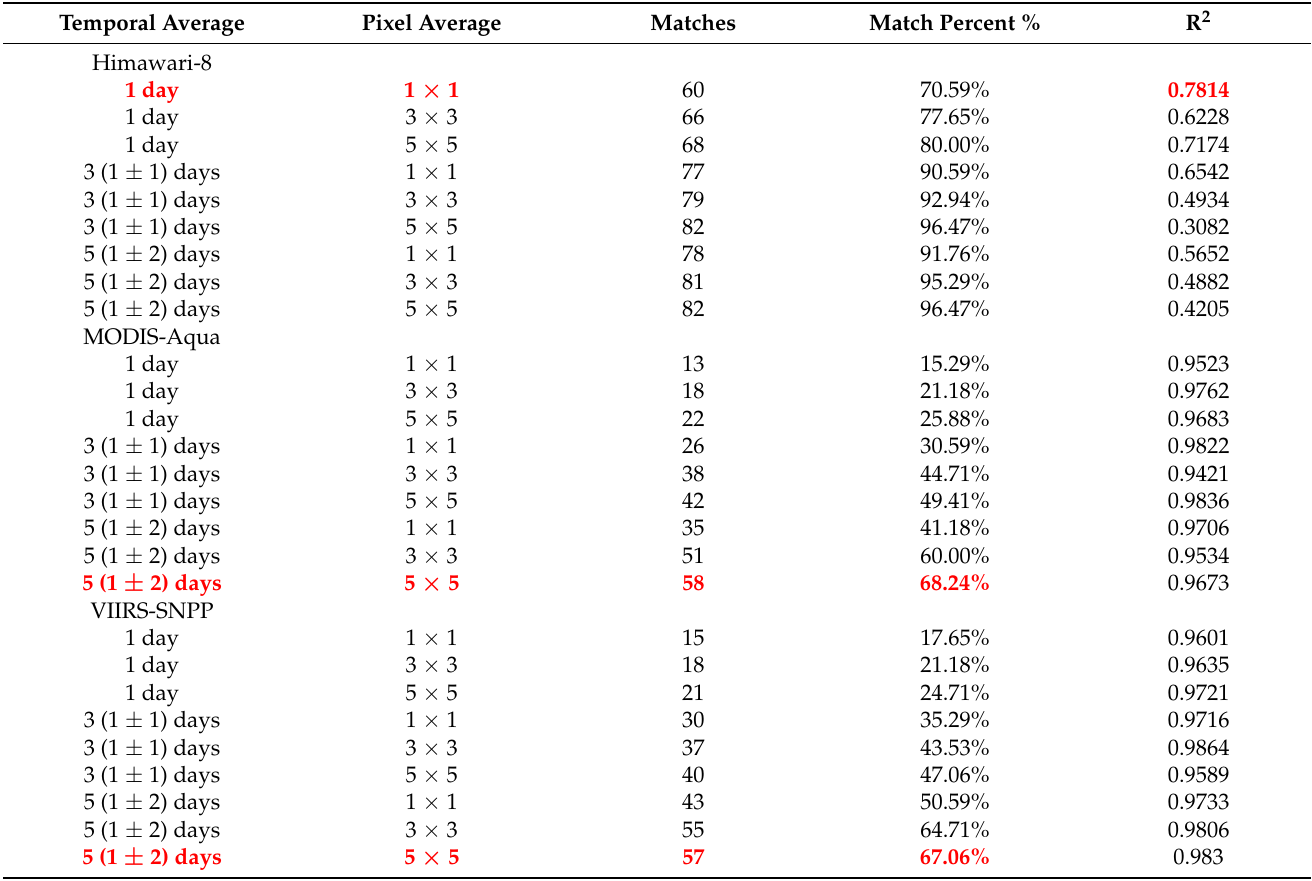
Table 3. Summary of in situ data and satellite data matchup results. The selected combinations and the basis of each selection are highlighted in red